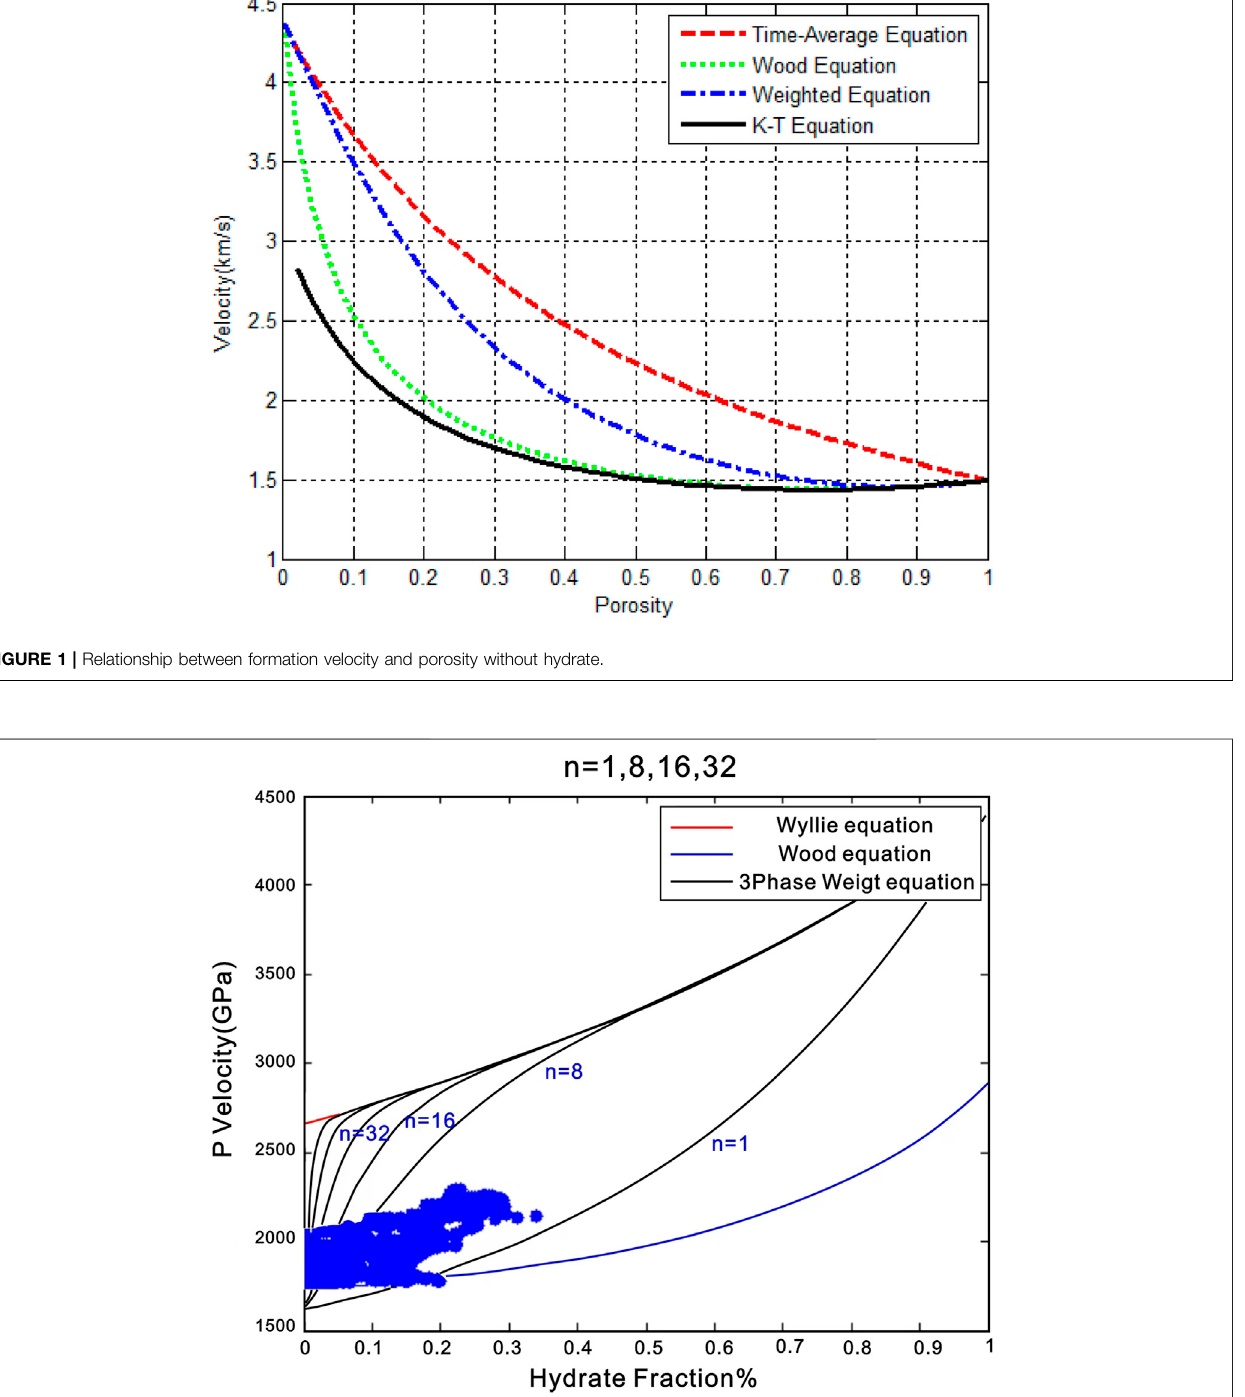
Frontiers in Earth Science |